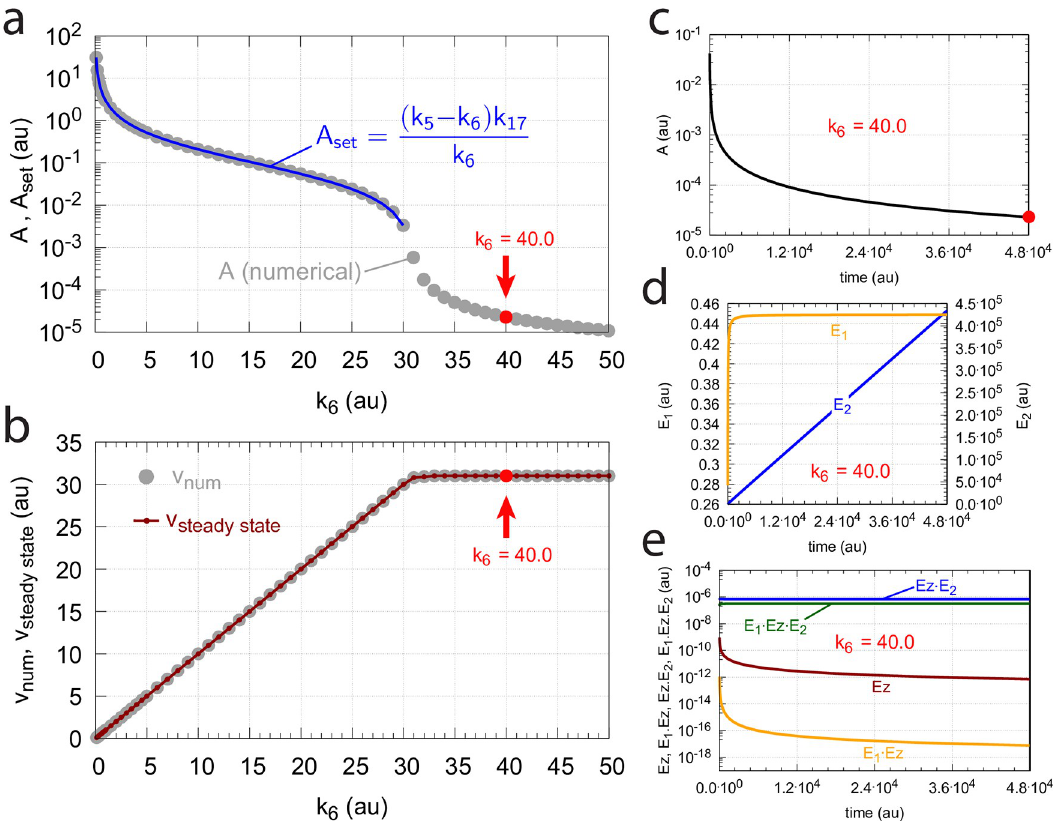
Fig 53. Loss of A -homeostasis in the m7 controller with a random-order ternary-complex mechanism (Fig 51) when k 6 > k 5 . (a) A ss as a function of k 6 . (b) v num (gray dots) and v steady state (King-Altman) (red line and small red dots) as a function of k 6 . (c) Decrease of A as a function of time when k 6 =40.0. (d) Steady state in E 1 and wind-up in E 2 when k 6 =40.0. (e) Time profiles of the different enzyme species. Rate constants: k 1 =100.0, k 2 =1.0, k 3 =0.0, k 4 =1 × 10 1 , k 5 =31.0, k 7 =1 × 10 8 , k 8 =0.1, k 9 = k 11 = k 13 = k 15 =1 × 10 8 , k 10 = k 12 = k 14 = k 16 =1 × 10 3 , k 17 =0.1. Initial concentrations: A 0 =2.5, E 1,0 =5.5, E 2,0 =52.1, Ez 0 =1 × 10 − 6 , (E 1 � Ez) 0 =0.0, (E 1 � Ez � E 2 ) 0 =0.0,